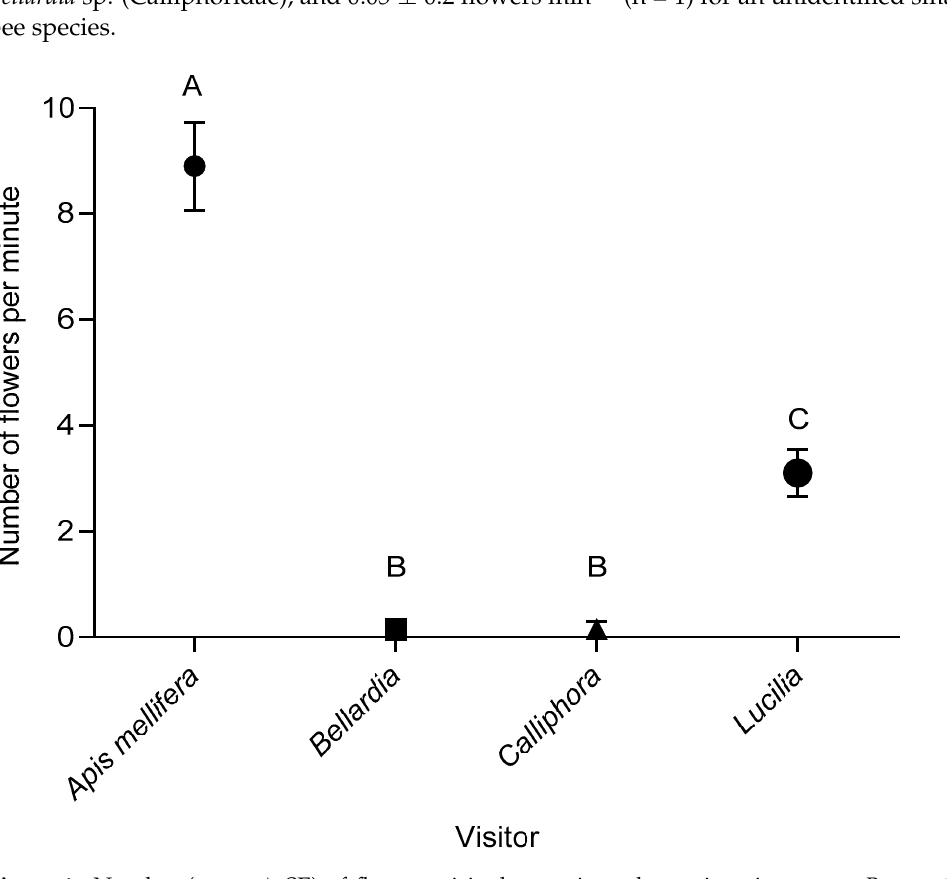
Figure 1. Number (mean ± SE) of flowers visited per minute by various insects on Pyracantha angustifolia in the grassland biome, Free State Province. Different letters indicate statistical significance (H-value = 62.68, p < 0.001, df = 3, Kruskal–Wallis).